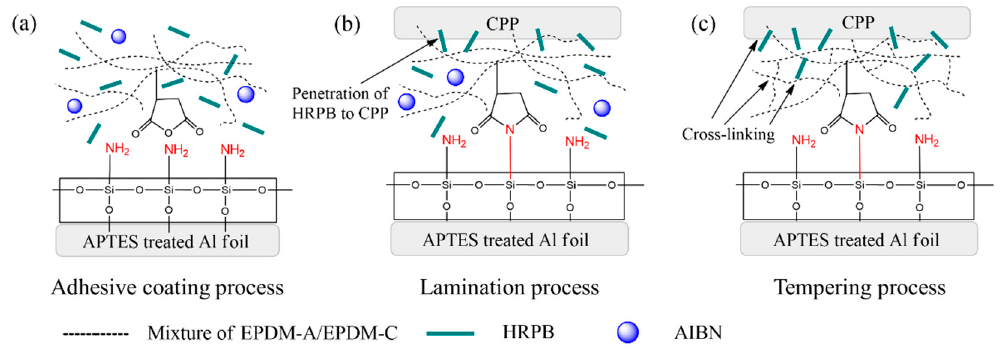
Figure 2. Overall scheme for CPP and Al foil adhesion. ( a ) The prepared adhesive is uniformly coated on the APTES treated Al foil using a bar coater; ( b ) The EPDM-A/EPDM-C form maleimide groups via imidization with the –NH 2 groups of APTES and wet onto CPP during lamination at 110 °C; ( c ) The mixture of EPDM-A/EPDM-C and HRPB form a cross-linked structure with CPP via radical polymerization during tempering.